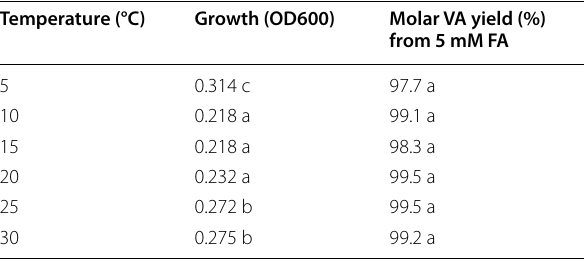
Data represent mean values of three replicates. Different letters (a-c) indicate statistically significant differences (LSD, p